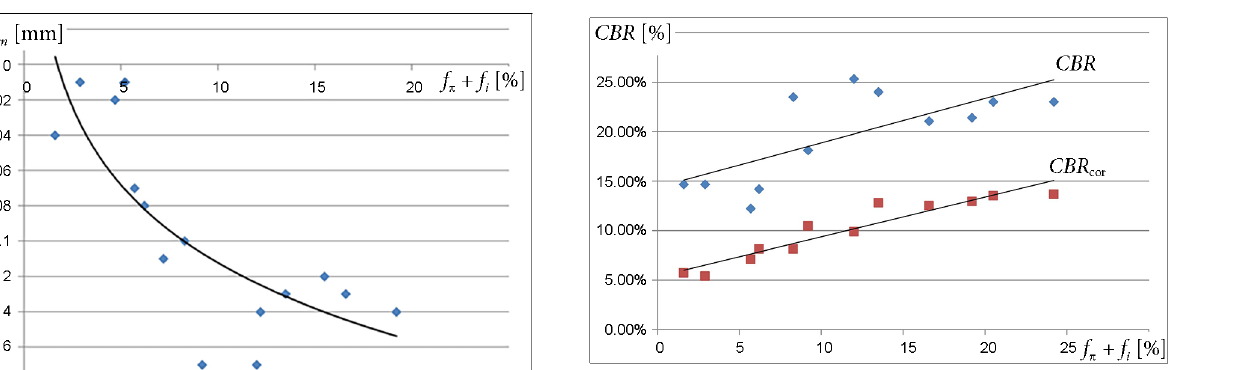
Figure 11. The dependence between the fine fraction content and the CBR